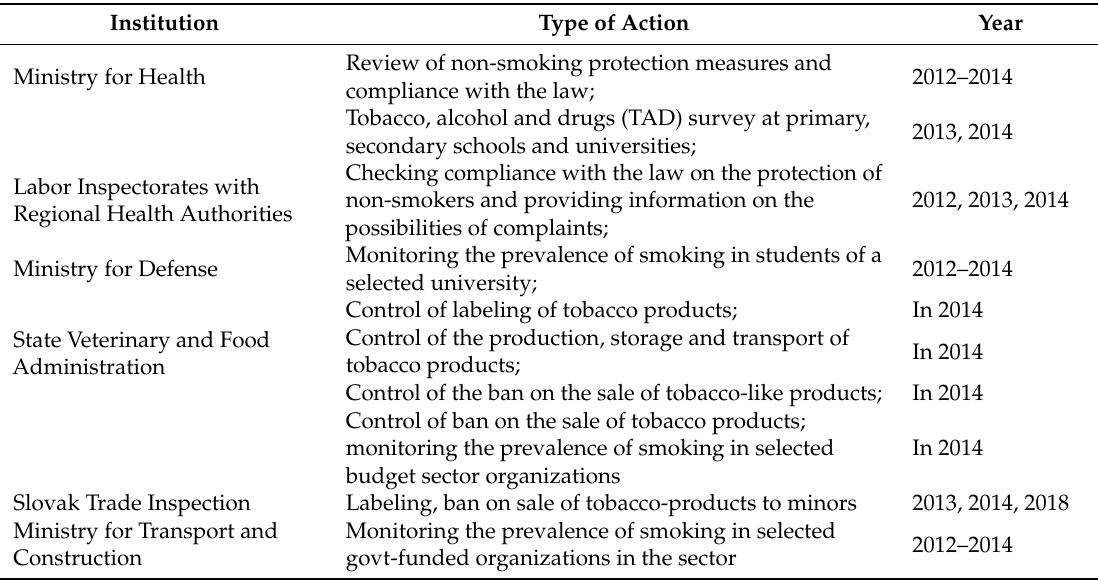
Table 2. Checks and monitoring actions in